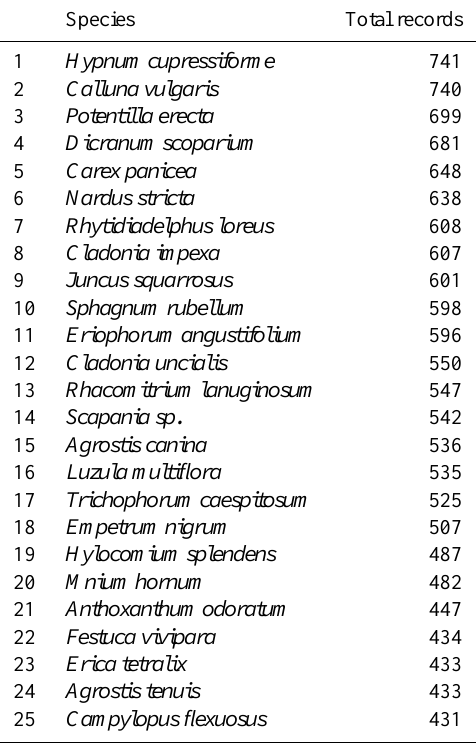
Table 4. List of the 25 most abundant species recorded in the sur-